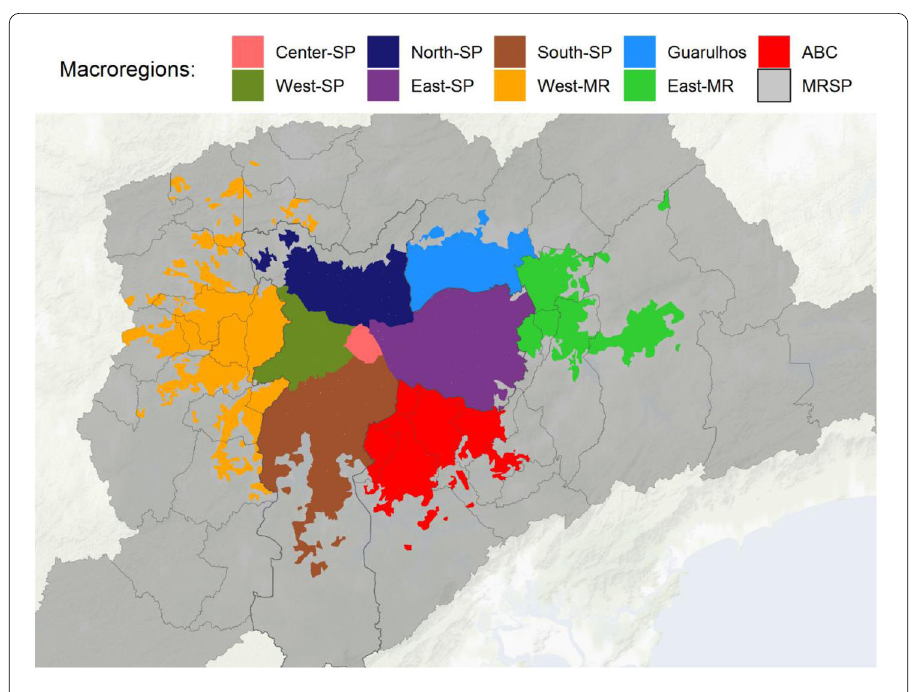
Figure 3 Macro-regions used for the TTI weighting. Each region was defined from the aggregation of TZs from the OD17. The regions within the city of São Paulo were defined according to the spatial division used by the São Paulo Traffic Authority (CET) to report their traditional congestion indicator at cetsp1.cetsp.com.br/monitransmapa/agora/. The regions composed of TZs from the other MRSP municipalities were defined by their geographic location. TZs without a sufficient number of observations on the UM platform were excluded. The area in gray corresponds to non-urban zones of the